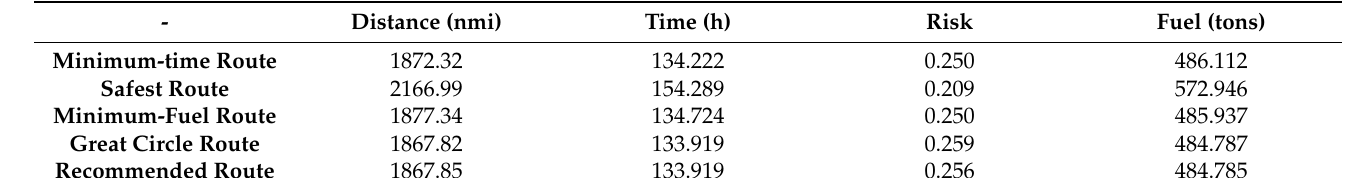
Table 5. Objective function values of five routes in good sea conditions.